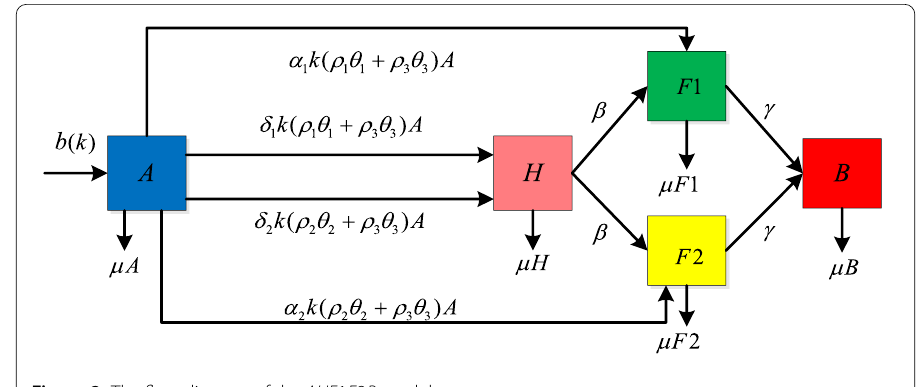
Figure 2 The flow diagram of the AHF 1 F 2 B